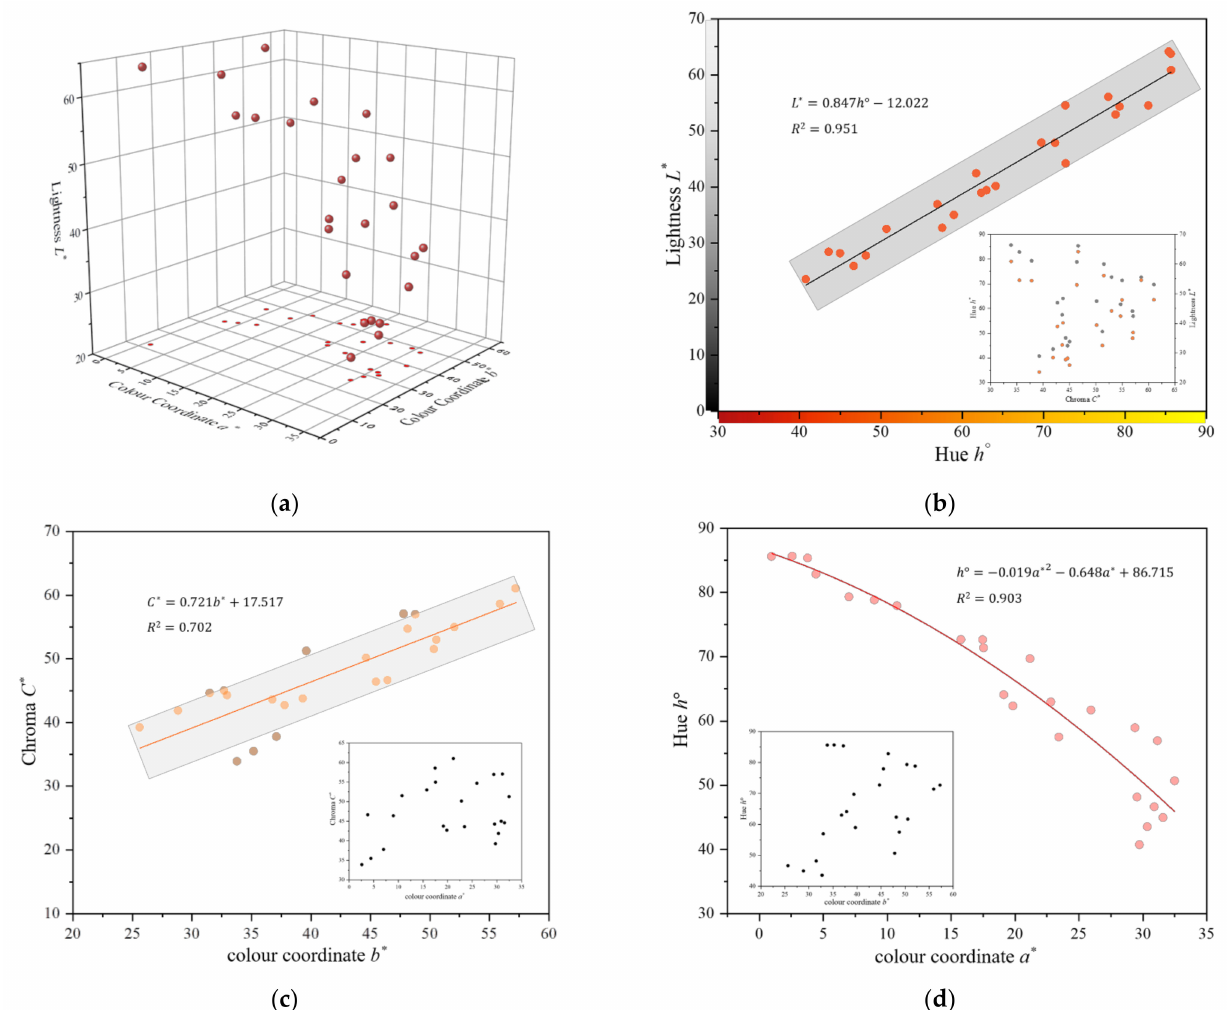
Figure 2. The colour analysis of Beihong agate samples. ( a ) 24 Beihong agate samples in CIE 1976 L*a*b* uniform colour space. ( b ) High positive correlation between the lightness L* and the hue angle h ◦ . ( c ) High positive correlation between the colour coordinate b* and the chroma C* . ( d ) High negative correlation between the colour coordinate a* and the hue angle h ◦